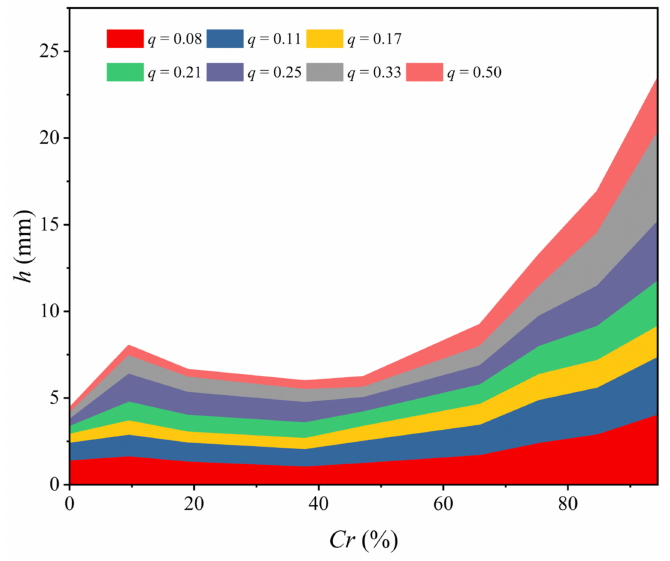
Figure 4. Relationship between water depth ( h ) and degree of coverage ( Cr